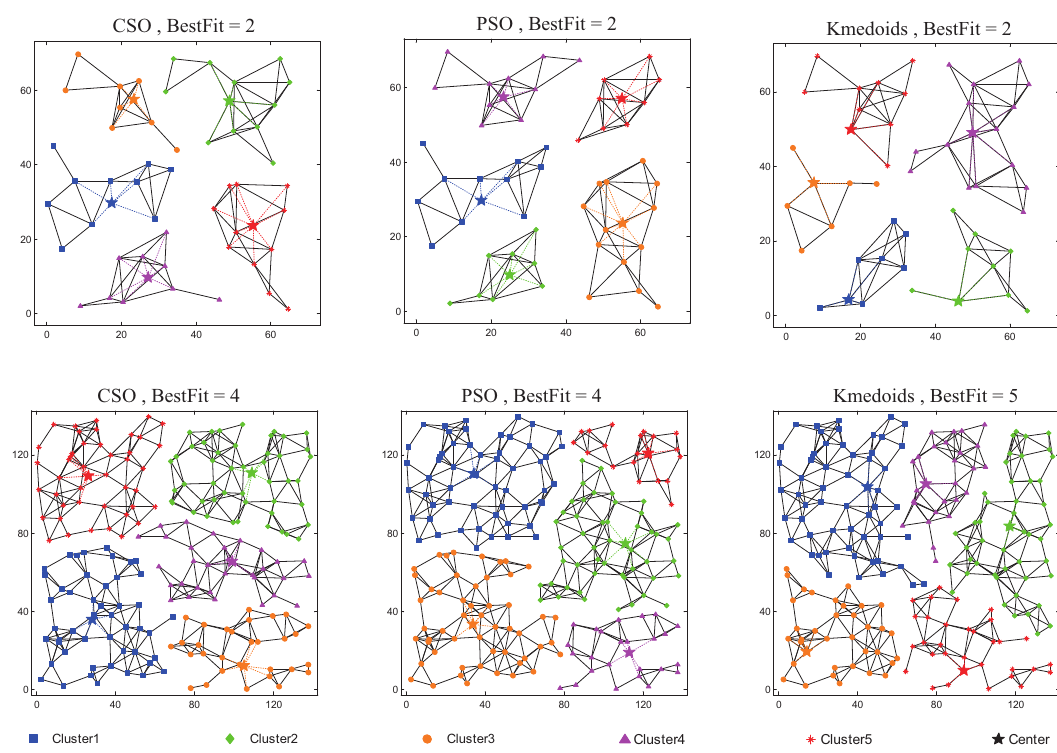
Figure 7. Optimization of three algorithms for networks of different sizes.